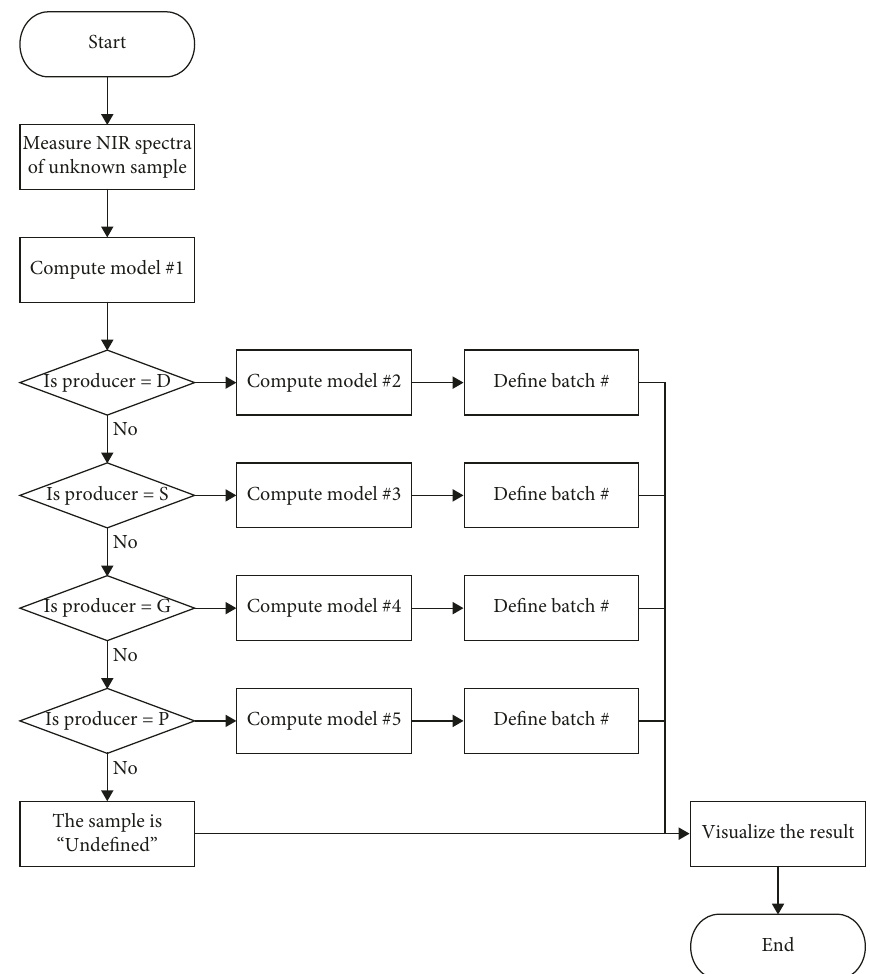
Figure 5: The algorithm of the prototype expert